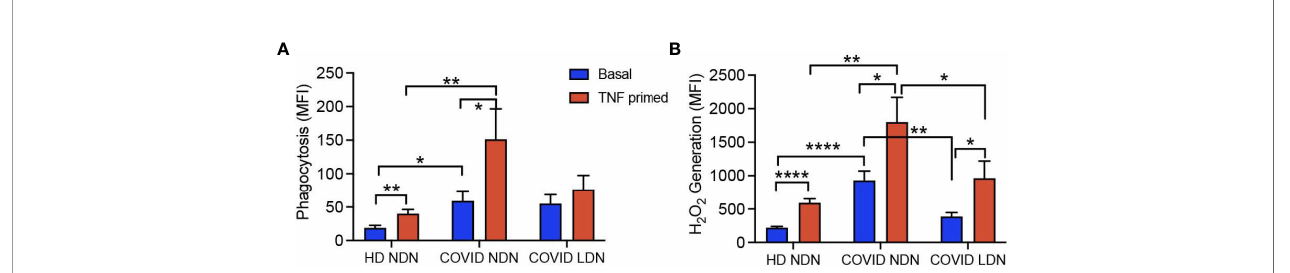
FIGURE 1 | Phagocytosis and respiratory burst are enhanced in COVID-19 NDN, but not LDN. Results show basal and in vitro TNF a -primed (2 ng/ml) phagocytosis of opsonized, propidium iodide-labeled S. aureus (A) and subsequent H 2 O 2 production (B) in COVID-19 NDN (n=11), LDN from COVID-19 (COVID LDN) (n=11), and NDN from healthy donors (HD NDN) (n=6). Results are expressed as mean ± SEM of mean fl uorescence intensity (MFI) of each marker, determined by fl ow cytometry. *p < 0.05, **p < 0.01, ****p <